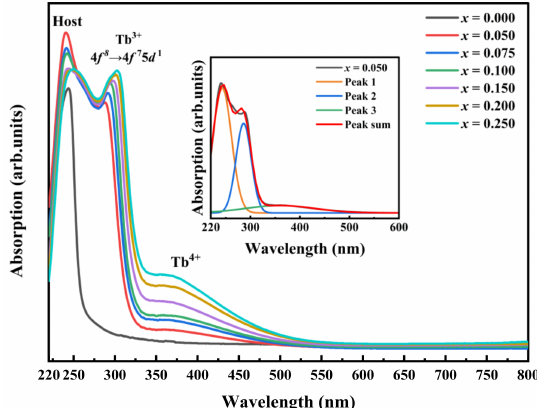
Figure 7. The absorption spectrum of (ZrO 2 ) 92 (Y 2 O 3 ) 8 − x (Tb 4 O 7 ) x ( x = 0.000–0.250) crystal discs before annealing (the inset is the result of Gaussian peak fitting of the absorption spectrum of the (ZrO 2 ) 92 (Y 2 O 3 ) 7.950 (Tb 4 O 7 ) 0.050 crystal). Transmission spectra of the (ZrO 2 ) 92 (Y 2 O 3 ) 7.800 (Tb 4 O 7 ) 0.200 crystal disks were also